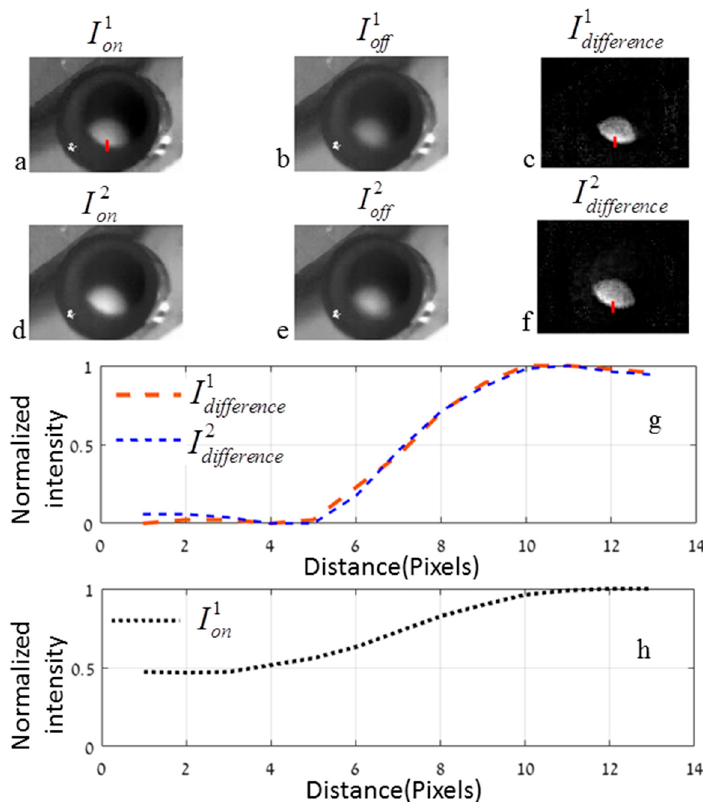
Figure 8. ( a , b ) and ( d , e ) Thermal images of the maximum and minimum temperature for two successive cycles; ( c , f ) Subtractions between the maximum and minimum in each cycle; ( g , h ) Intensity profile of the cross-sections marked with red lines in ( c , f ) and ( a ), respectively.